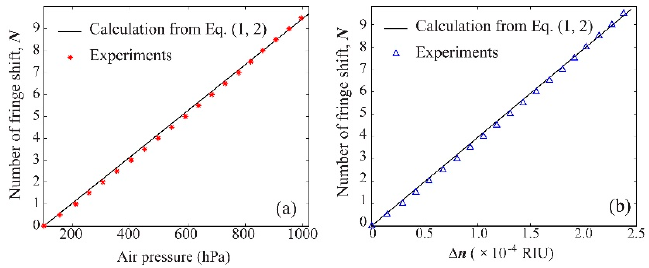
Figure 4. ( a ) Fringe shifts in response to variations in air pressure in the air channel. ( b ) Fringe shifts in response to variations in the refractive index of gas filled in the air channel of the DCF.